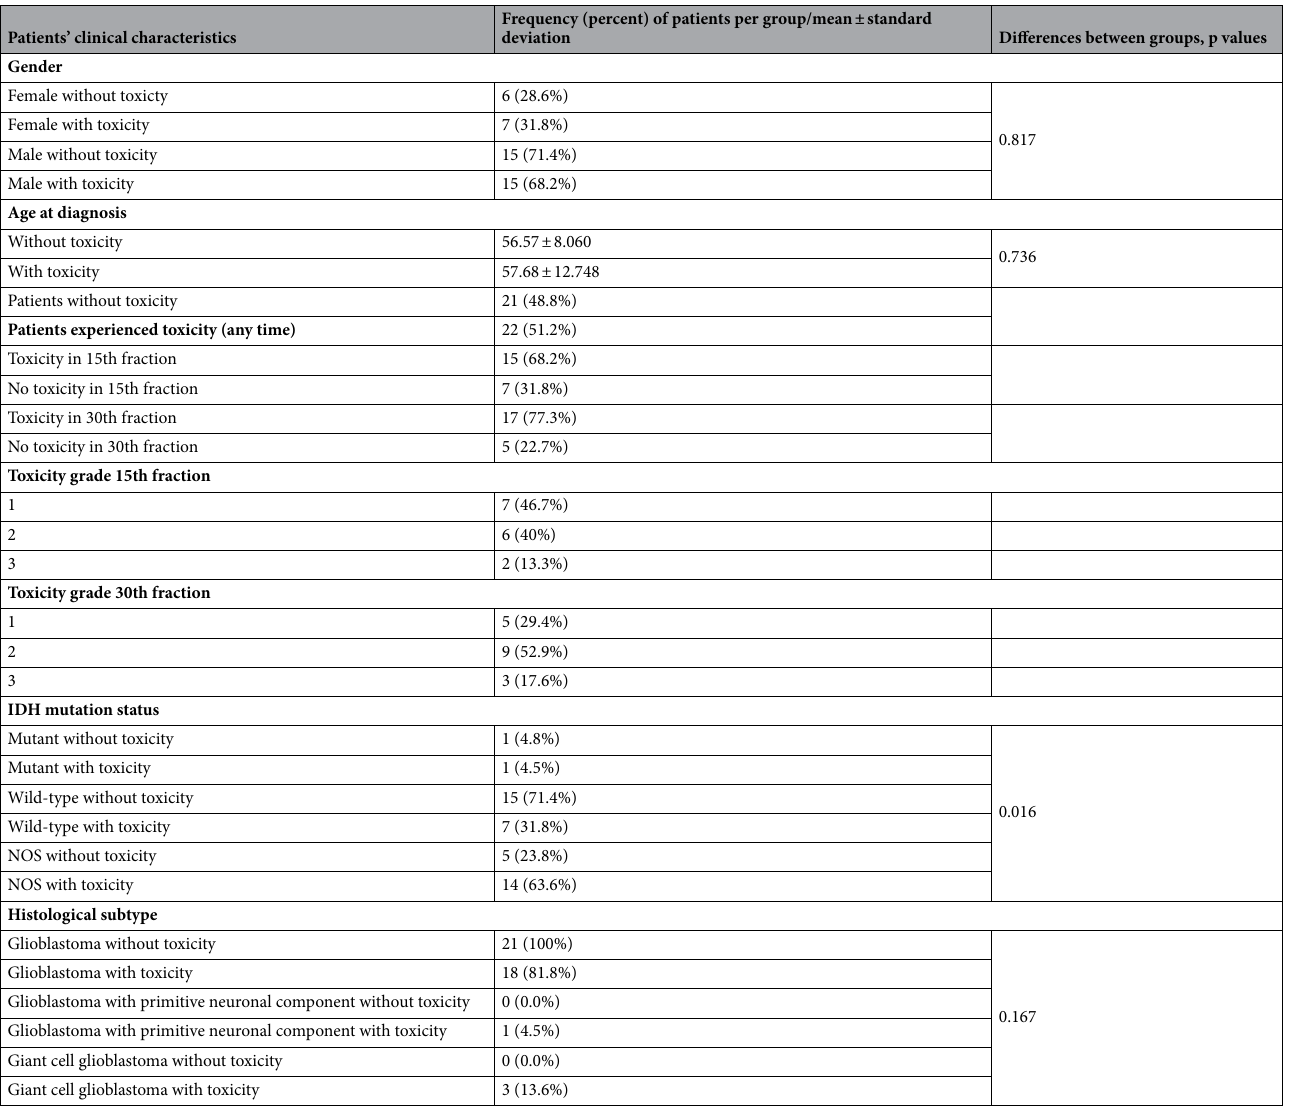
Table 1. Patients’ clinical characteristics: differences between groups of patients with and without toxicity- description of groups. Age at diagnosis was presented as means ± standard deviation. NOS not otherwise